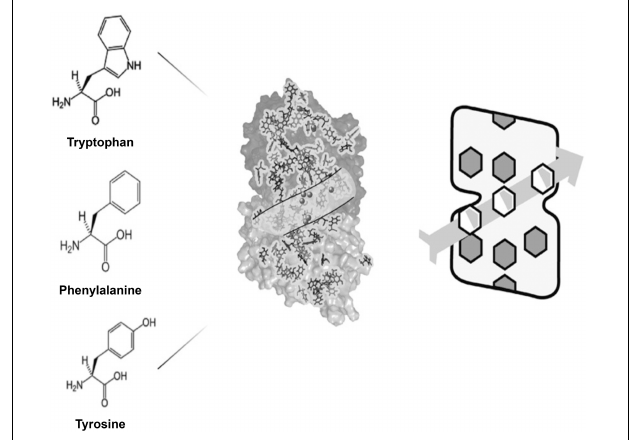
FIGURE 6 | Left: 3 aromatic amino acids with pi resonance indole (tryptophan), and phenyl/benzene rings (phenylalanine, tyrosine). Middle: tubulin with its 86 pi resonance rings (spheres show anesthetic binding sites). Right: A simplified model representing dipole couplings among 3 rings along a helical pathway in a